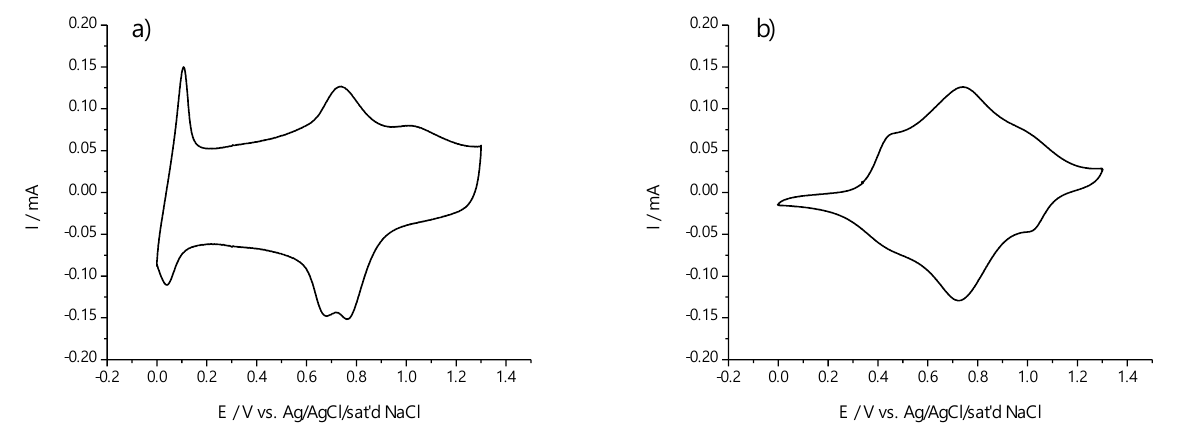
Figure 4. Cyclic voltammograms of the polymeric films poly-Ni(3-MeOSalen) ( a ) and poly-H 2 (3-MeOSalen) ( b ) in 0.1 mol dm −3 Et 4 NBF 4 /AN, 0 – 1.30 V, v = 0.05 V s −1 .